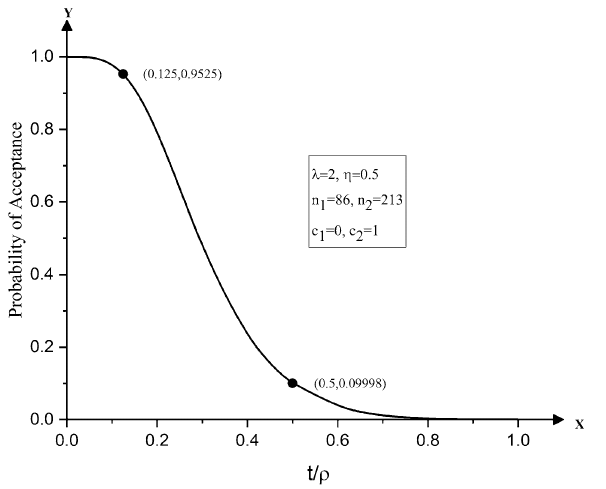
Figure 3. OC curves of double sampling plans for life tests based on Pareto type IV distribution with = 86, n = 213, (cid:31) = 2 and η = 0.5 n 1 2